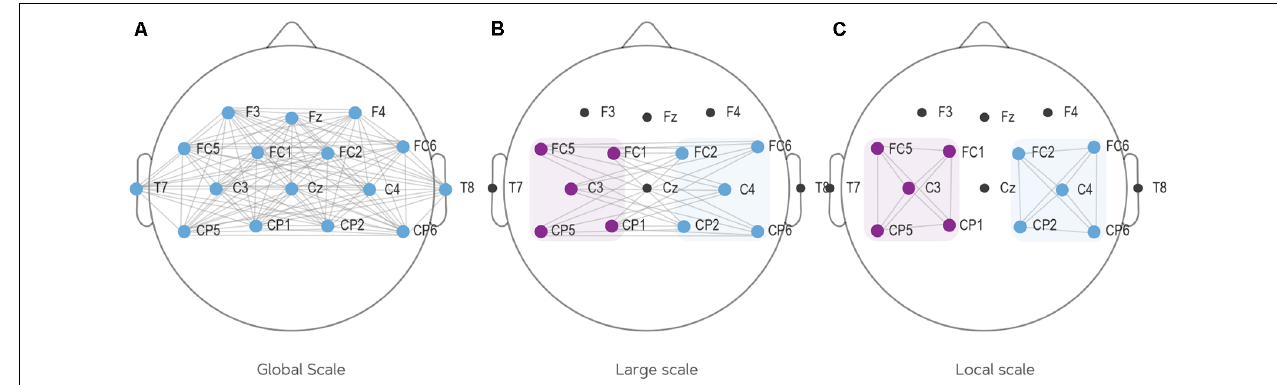
FIGURE 2 | The three scales of connectivity employed in this study. (A) Global scale connectivity: computes average PLV of all electrodes. (B) Large scale connectivity: computes average PLV from the left to the right hemisphere. (C) Local scale connectivity: computes local connectivity on two locations: the left hemisphere (C3 and all surrounding electrodes) and the right hemisphere (C4 and all surrounding electrodes). PLV, phase-locking